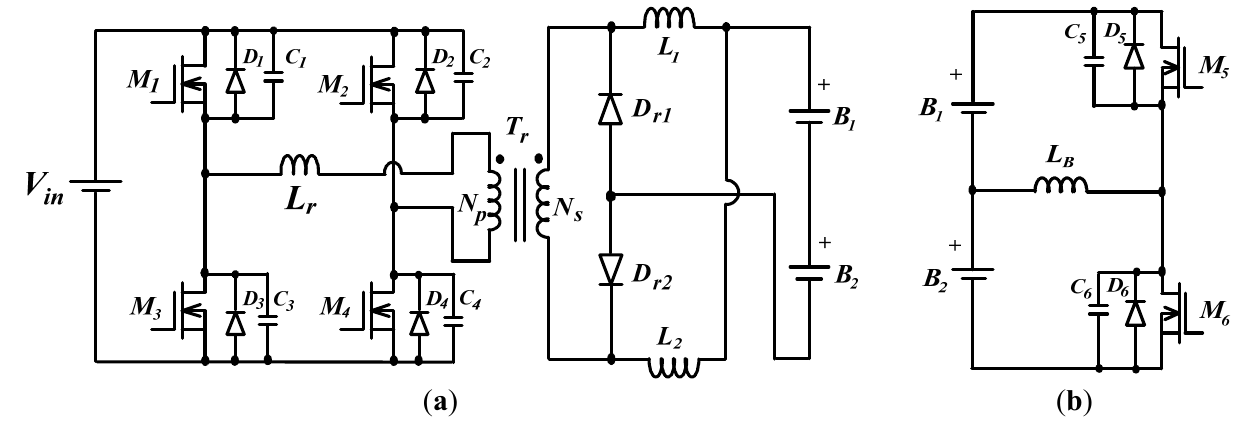
Figure 5. Two equivalent circuits of the proposed energy storage system: ( a ) charging mode; ( b ) voltage equalization